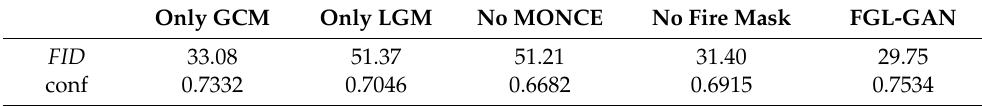
Table 2. Comparison of FID and yolov5 confidence in different situations of ablation study.